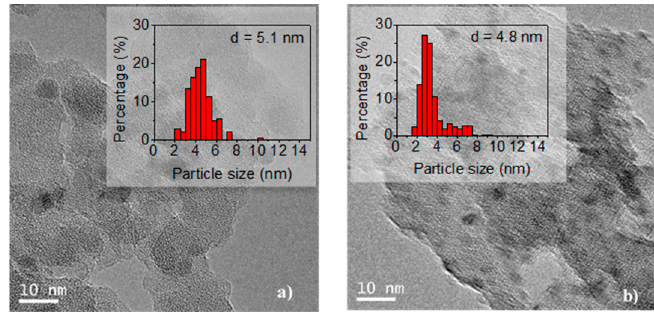
Figure 5. Transmission electron microscopy (TEM) images of reduced samples: ( a ) Ni/SiO 2 and (b ) Ni/Ca(19.3)-SiO 2 ; the histograms were included.